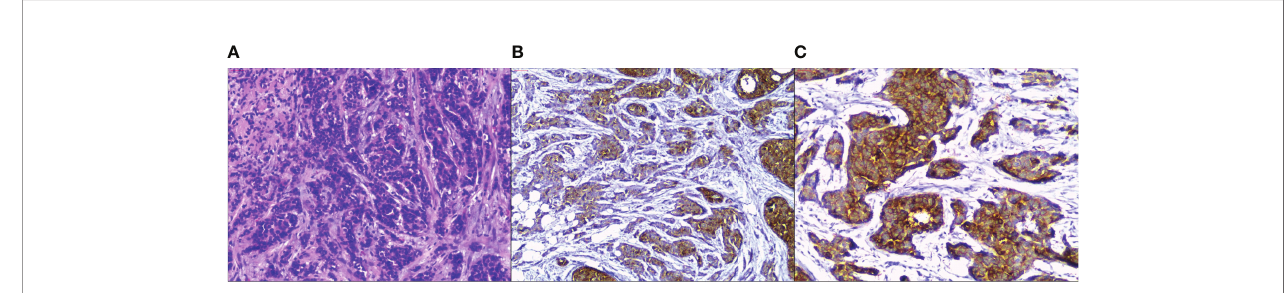
FIGURE 1 | Pathological fi ndings in primary neuroendocrine carcinoma of the breast. (A) H&E stain, tumor cells are composed of dense cellular solid nests, some of which are arranged in alveolar, with round or short spindle cells and eosinophilic cytoplasm. (B) Tumor cells show different degrees of positive expression for Chromogranin A on immunohistochemistry. (C) Tumor cells show strong and diffuse synaptophysin expression. (Hematoxylin-eosin, original magni fi cation ×100 (A) ; original magni fi cation ×100 (B, C)